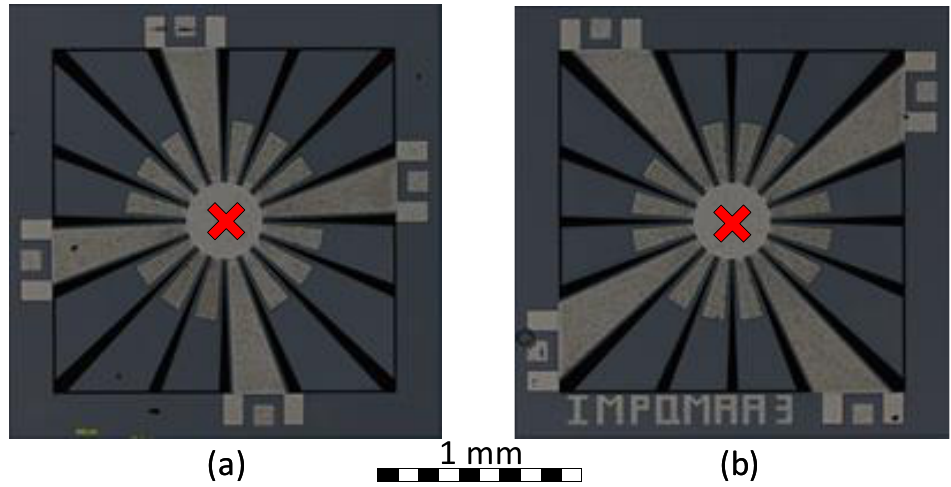
Figure 5. Micrograph of the fabricated SD devices: ( a ) Variant 1 (hardening) and ( b ) Variant 2 (softening). The different anchoring schemes for each structure can be identified, along with an indication of the vibration measurement point